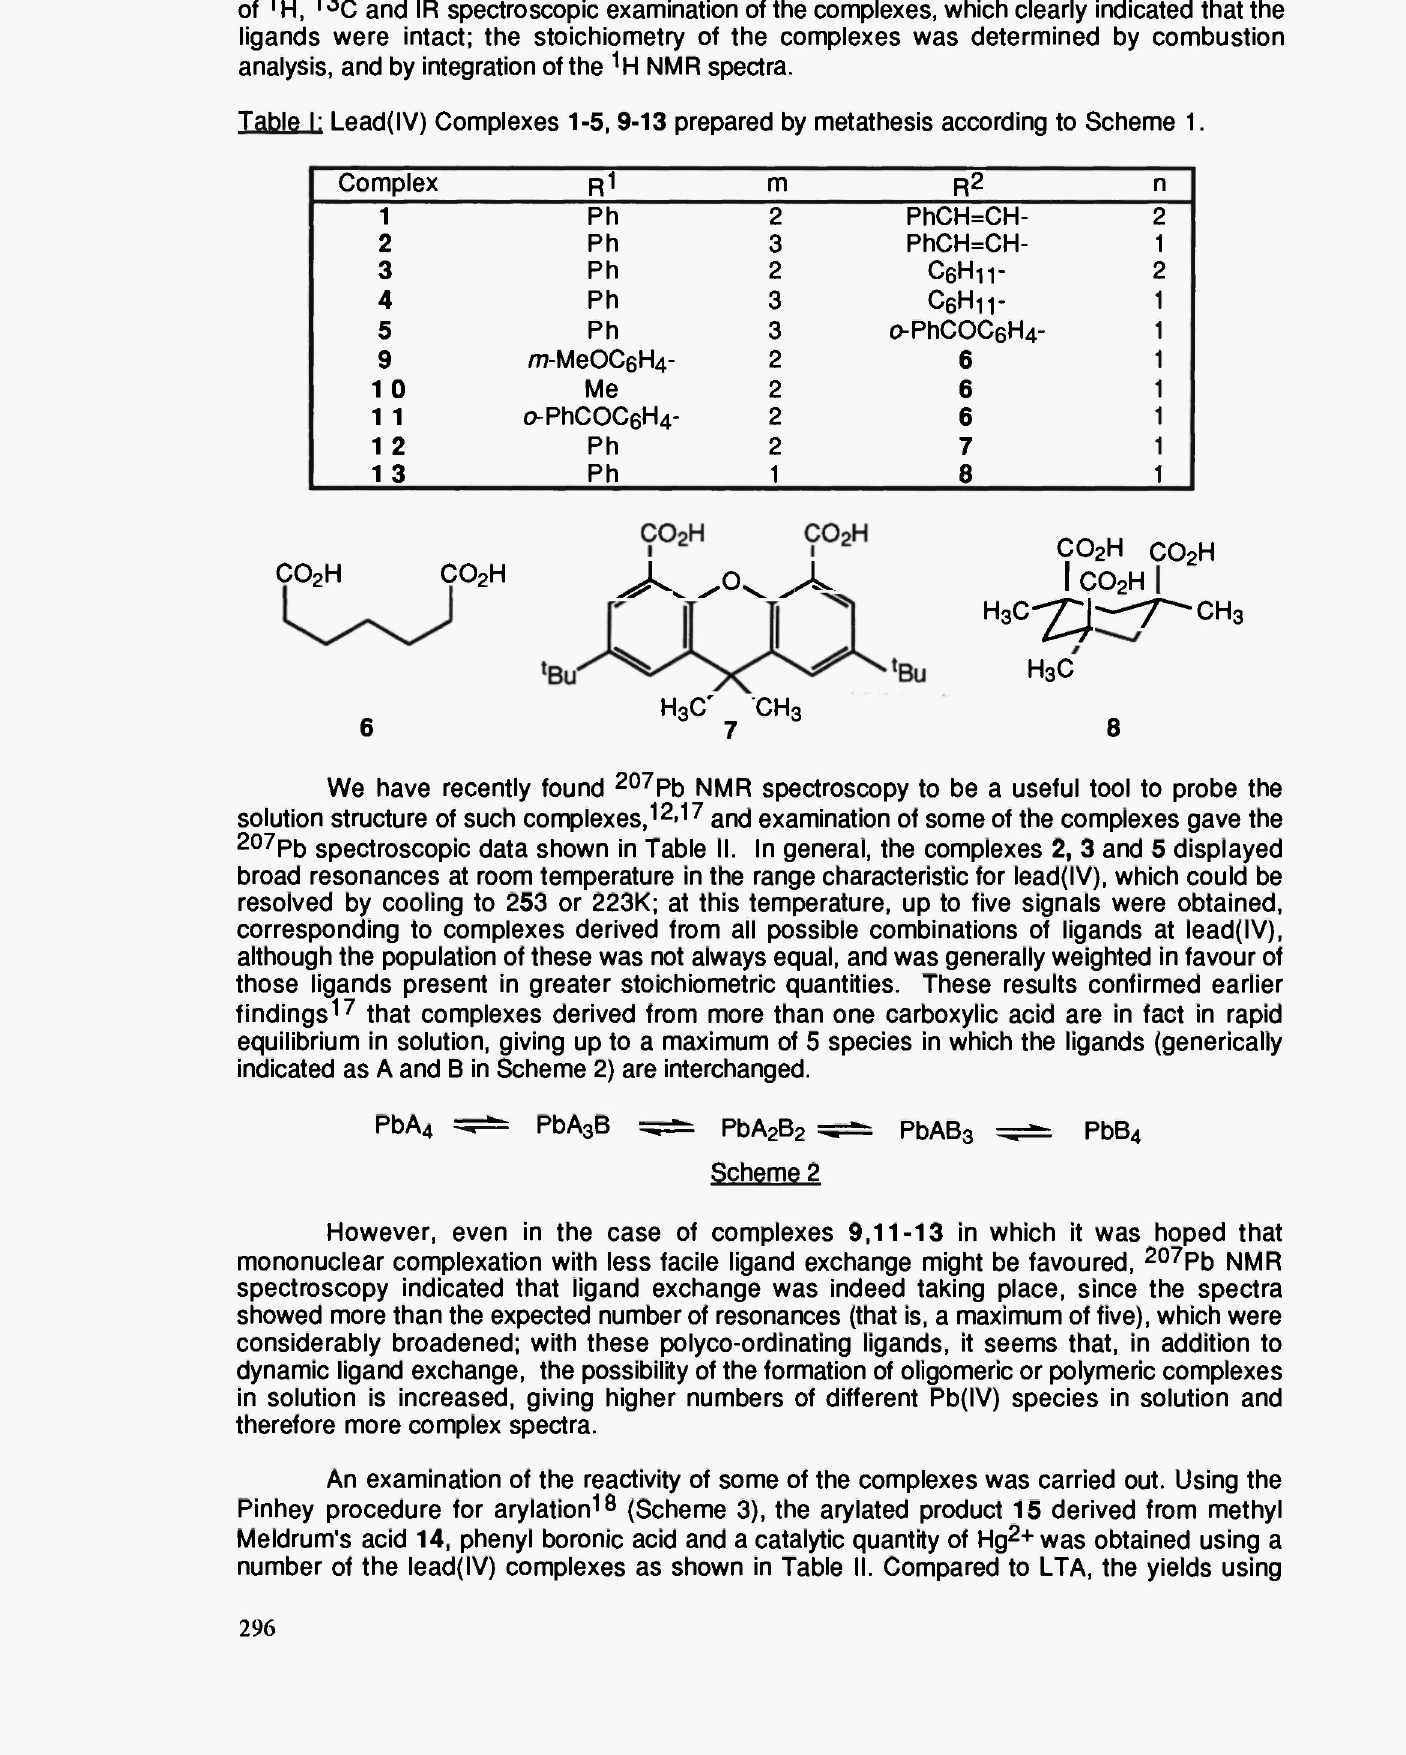
Table I: Lead(IV) Complexes 1-5, 9-13 prepared by metathesis according to Scheme